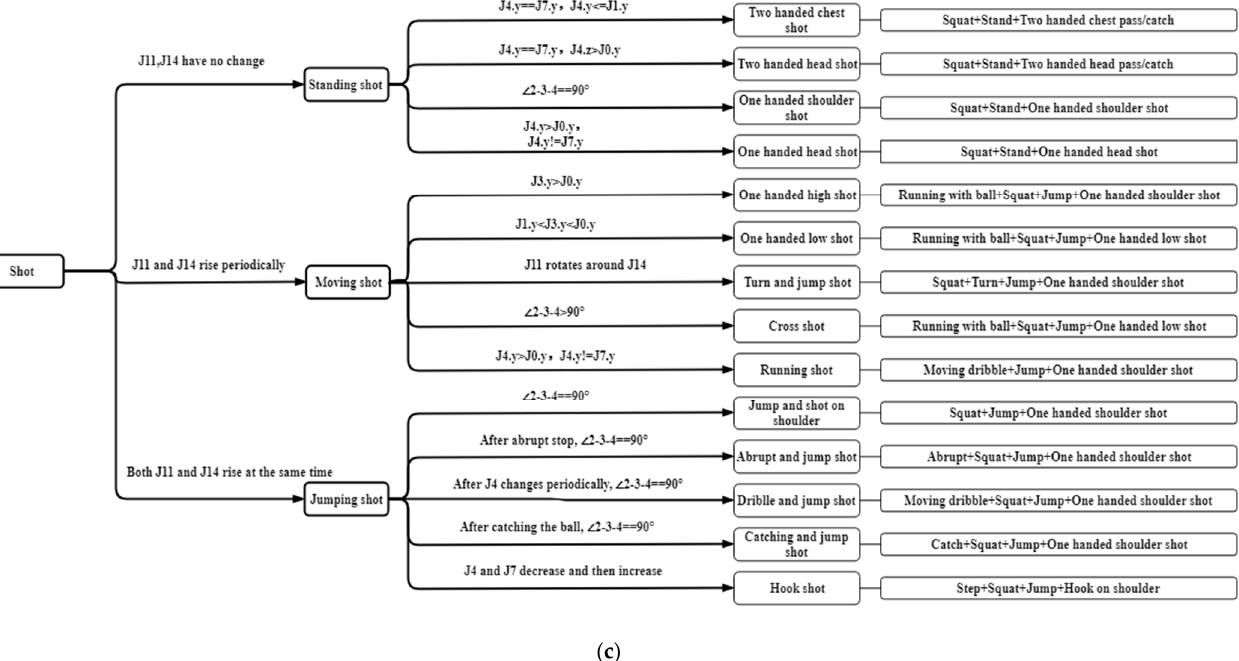
Figure 2. The definitions and a decomposition of all complex basketball movements. From top to bottom, it is the detailed action classification of ( a ) movement, ( b ) ball control, and ( c ) shots in basketball.